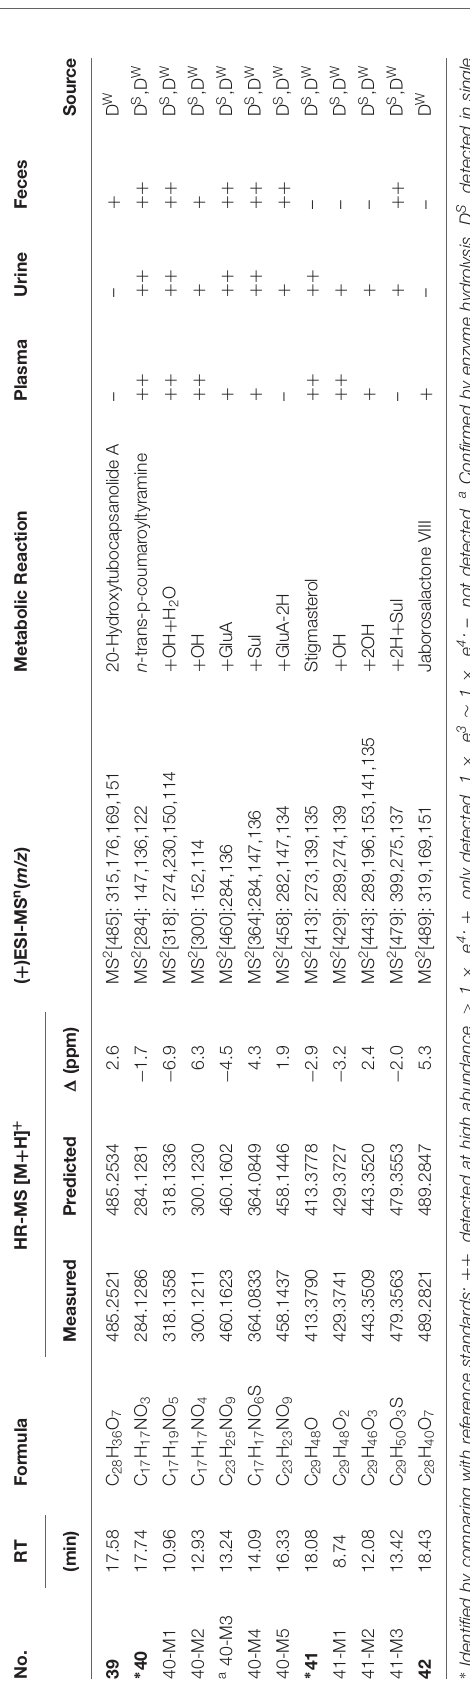
( Figure 3 ), including 18 withanolides, 14 withanolide glucosides, six amides, one indole, one triterpenoid, one steroid, and one sesquiterpenoid. Among them, 17 compounds ( 1 , 3 , 5 , 9 , 10 , 13 , 18 , 19 , 20 , 22 , 29 , 30 , 31 , 32 , 36 , 40 , and 41 ) were unambiguously identified by a comparison with reference standards. Another 25 potential constituents ( 2 , 4 , 6 , 7 , 8 , 11 , 12 , 14 , 15 , 16 , 17 , 21 , 23 , 24 , 25 , 26 , 27 , 28 , 33 , 34 , 35 , 37 , 38 , 39 , and 42 ) were tentatively characterized based on their retention times, UV spectra, high-accuracy mass spectra, and MS/MS fragmentation behaviors. Chemical structures of the single compounds characterized in WDS are given in Figure 2 .